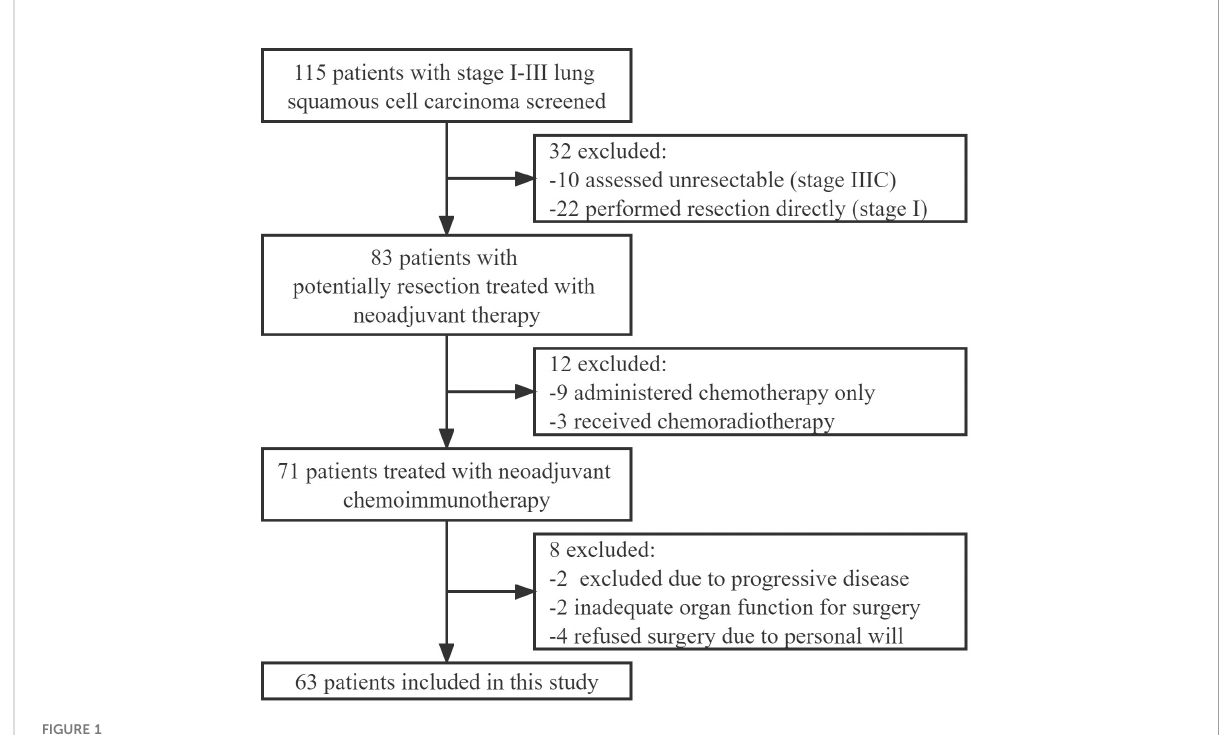
FIGURE 1 Flow diagram of patients included in this